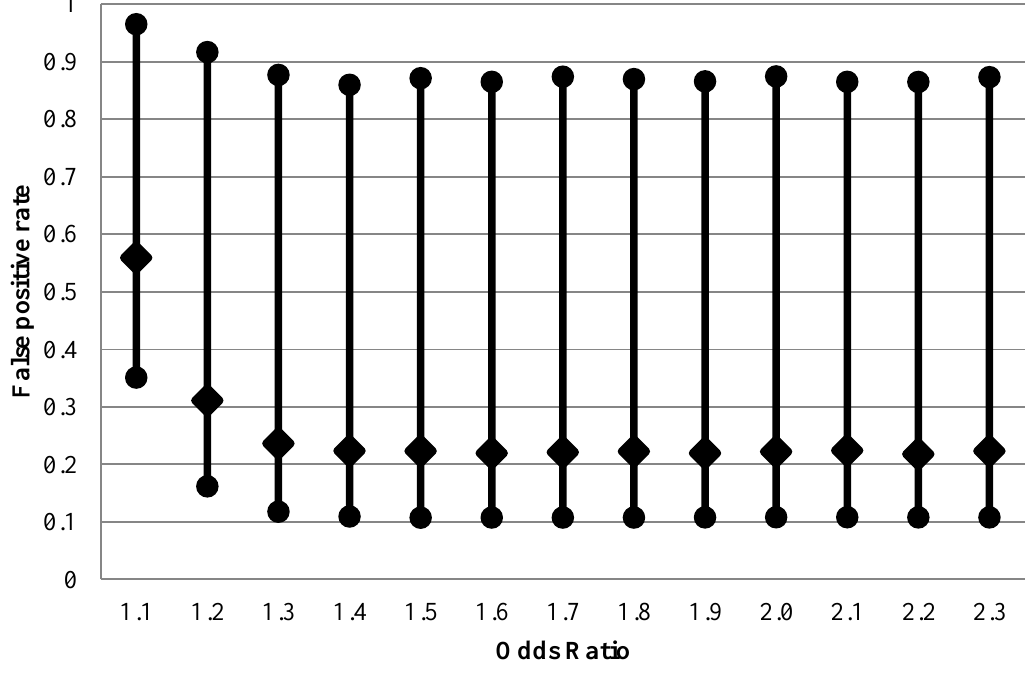
Figure 1. Impact of effect size on false positive rate (2.5th, 50th and 97.5th percentiles of 20,000 Monte-Carlo simulations) for fixed distribution of belief about probability of the effect being null (1500 case-control sets, type I error 5%, prevalence of exposure 30%, perfect exposure